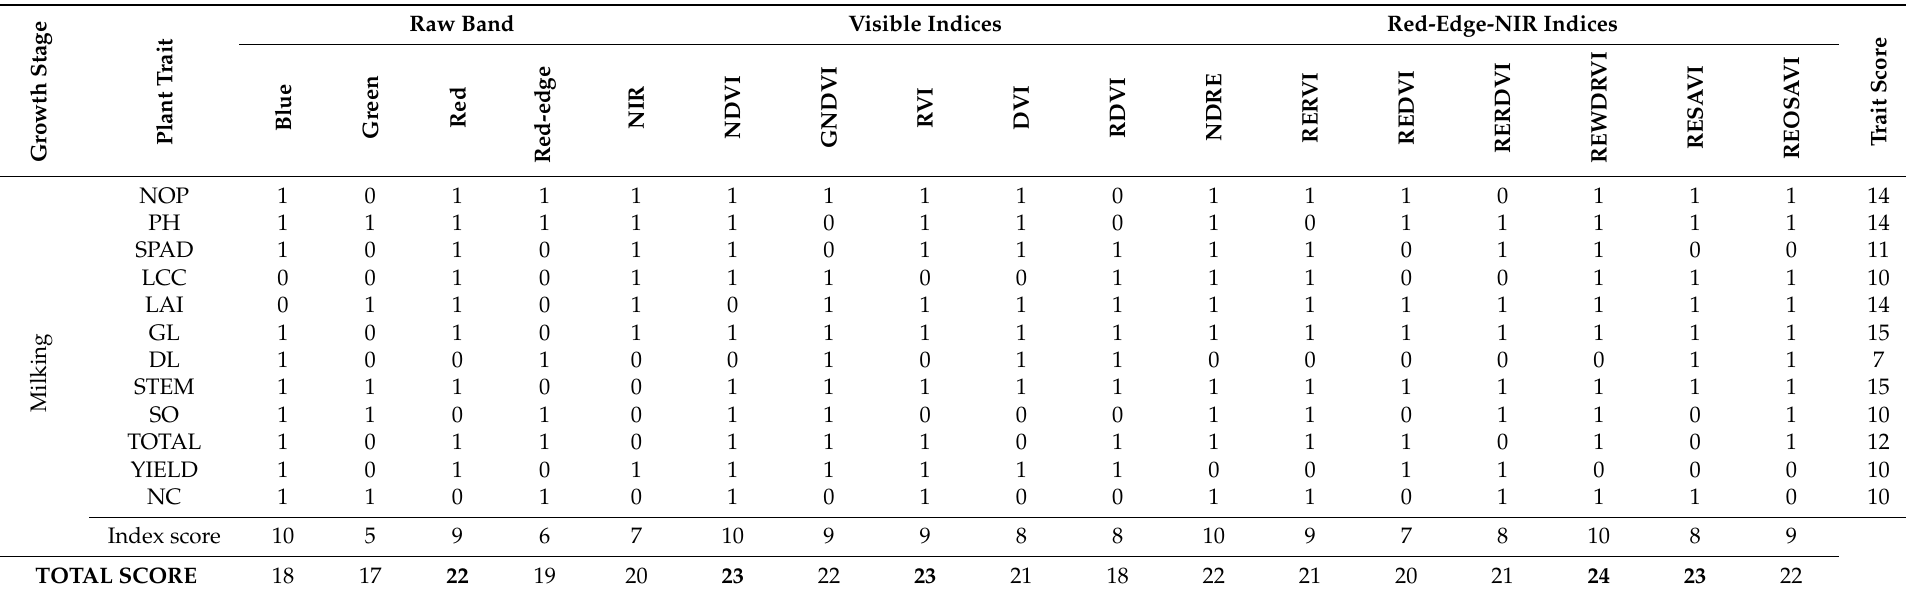
Table 6. Index and trait score for all plant traits and indices at